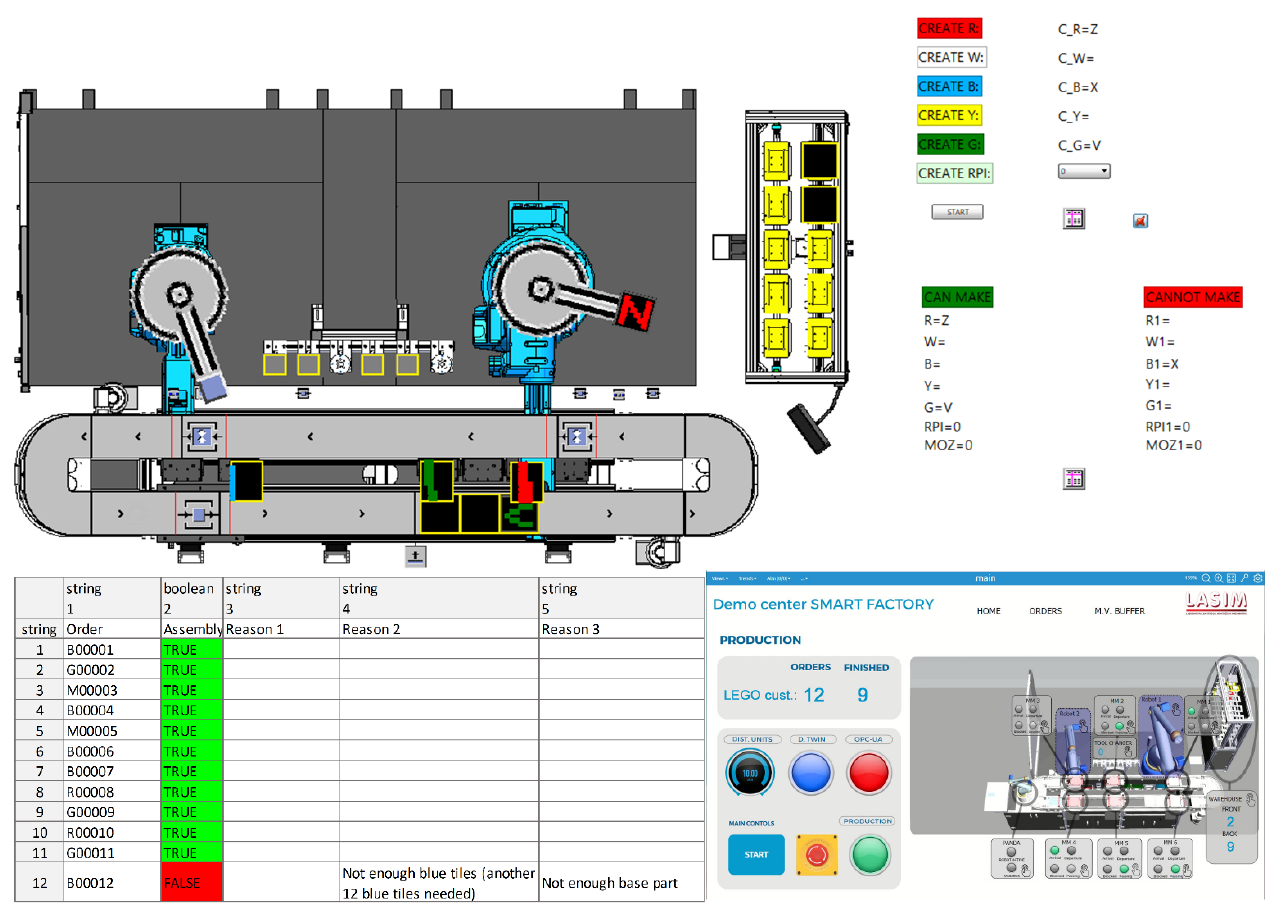
Figure 17. The digital twin of the Demo Center Smart Factory.